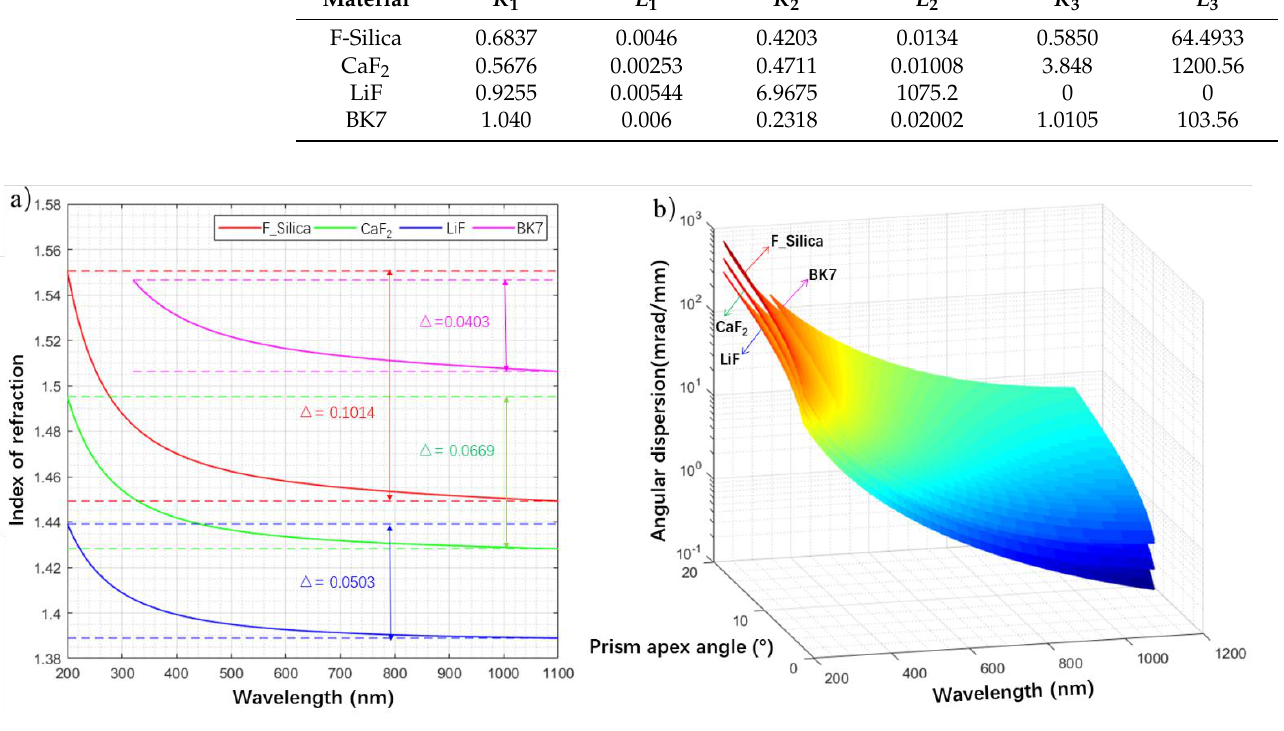
Figure 3. ( a ) Index of refraction versus wavelength. ( b ) Angular dispersion corresponding to different wavelengths and prism apex angles.